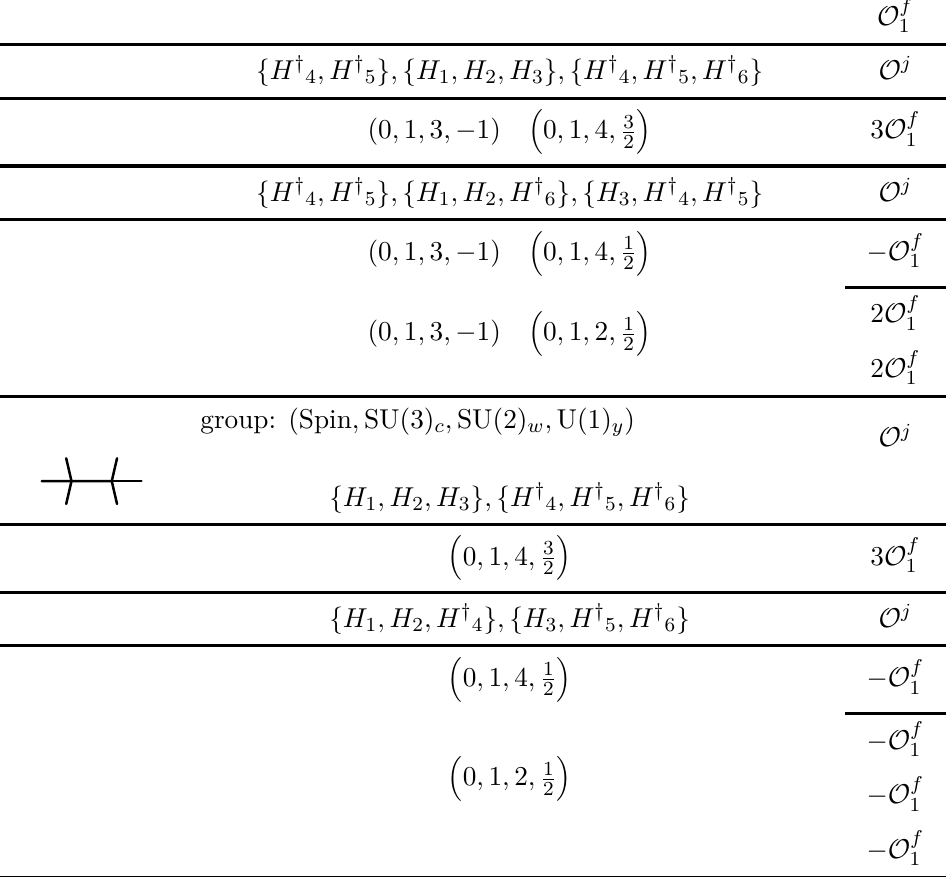
Table 24. UV resonance of topology dim6-6. “*” in front of each row indicates topologies with nonrenormalizable vertices. The UV resonances colored in gray are eliminated by UV